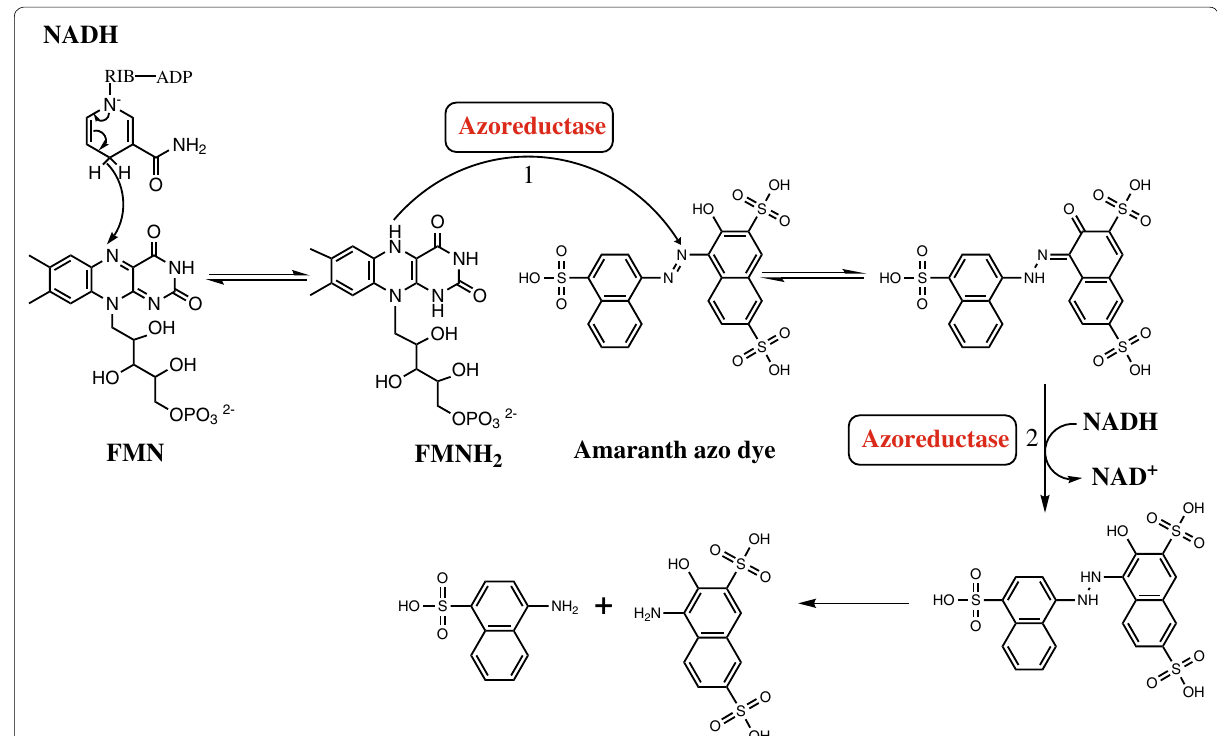
Fig. 3 Proposed azoreductase mechanism for Amaranth azo dye degradation: step 1. Upon oxidation of NADH, the hydride is transferred to FMN present in the active site of azoreductase. Substrate (Amaranth azo dye) binds to one of the active sites of azoreductase. Then the reduced FMN transfers the hydride to Amaranth azo dye. Step 2 is another cycle of hydride transfer from NADH to Amaranth azo dye via